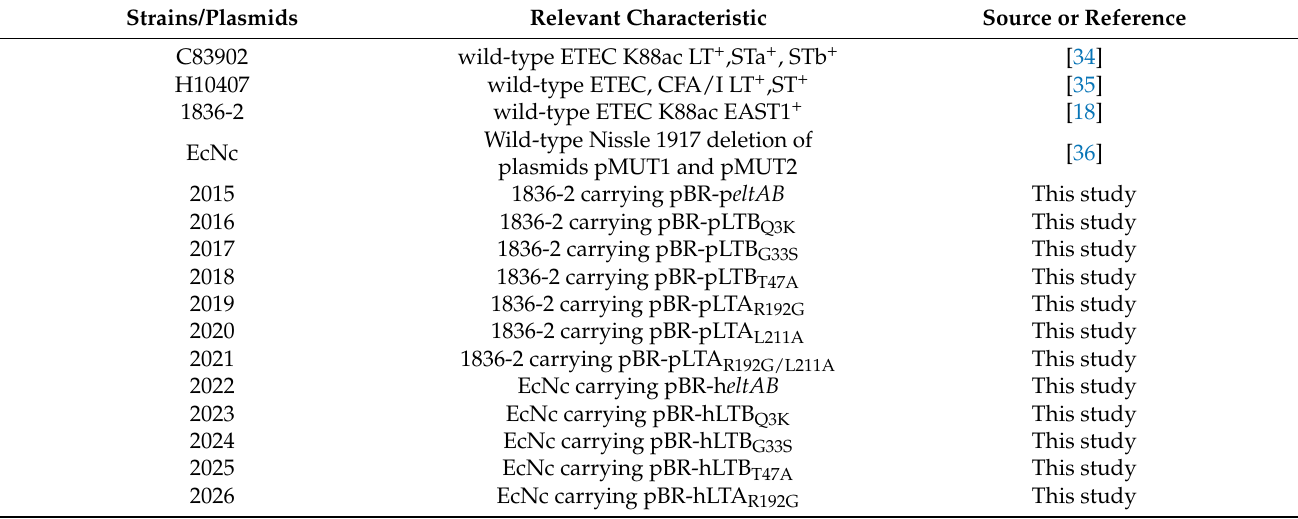
Table 1. Strains and plasmids used in this